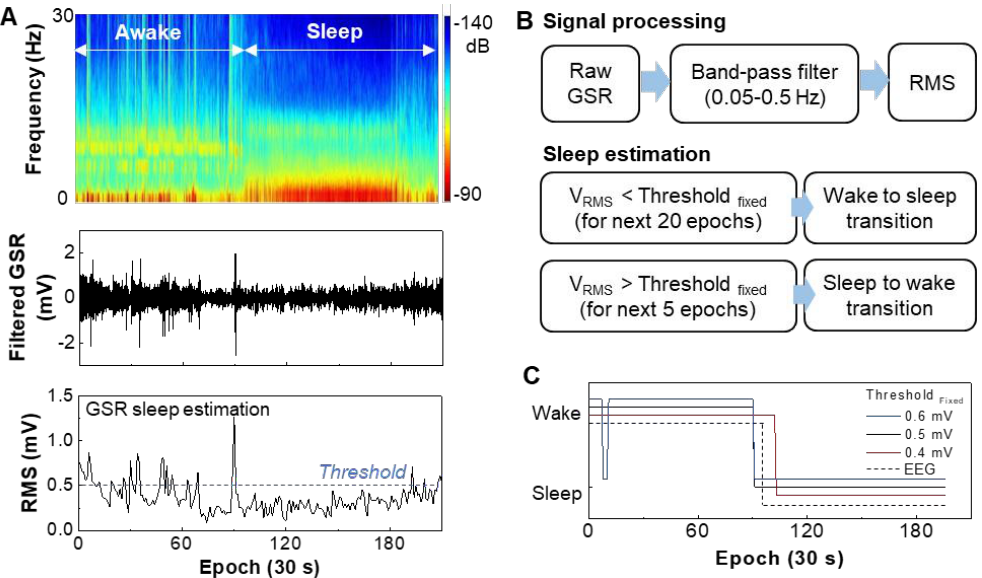
Figure 3. Determination of the wake-sleep transition based on GSR signals and validation with EEG signals. ( A ) EEG spectrogram measured on the forehead that differentiates the transition between awake and sleep (top), band-pass filtered GSR data measured on the wrist (middle), and RMS data from the filtered GSR for determination of sleeping (bottom). ( B ) Signal processing method of GSR data and sleep estimation process based on the RMS threshold. ( C ) Optimization of the threshold values to determine the sleeping transition in comparison with the EEG data.